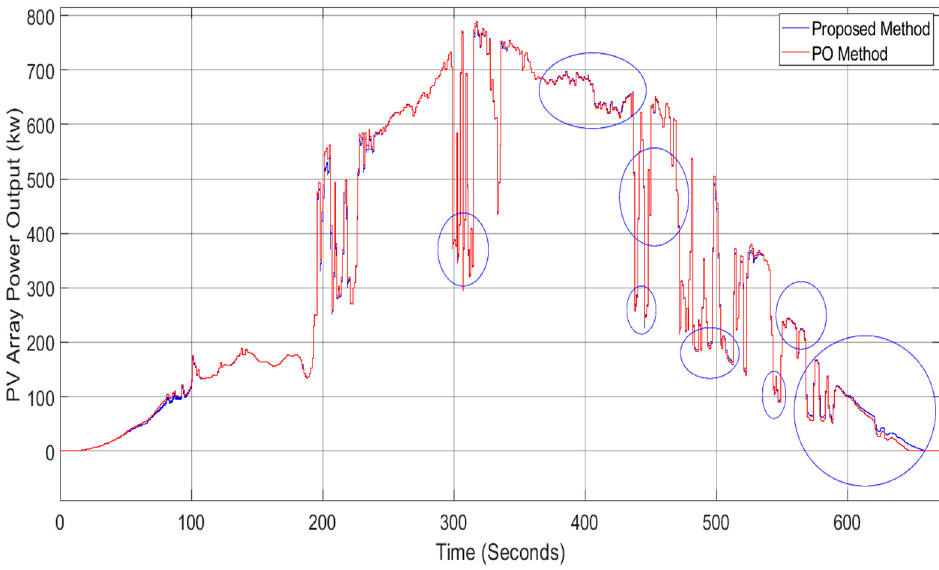
Figure 8. Output power of the proposed method and the PO method on a cloudy day.